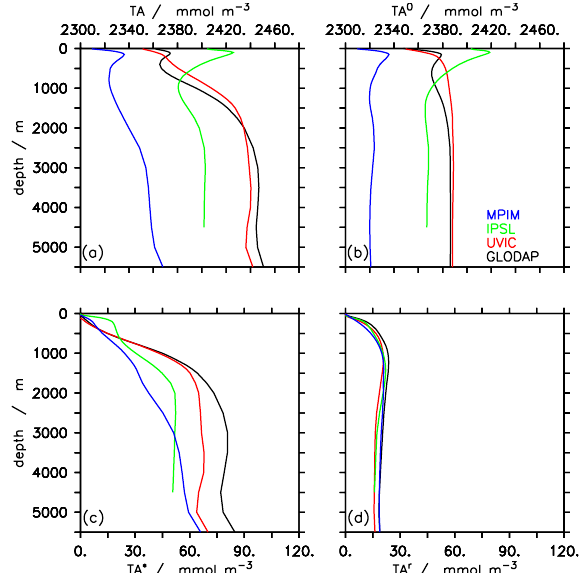
Figure 11. Global mean profiles of (a) TA, (b) TA 0 , (c) TA ∗ and (d) TA r in the GLODAP data set and in three different models. Prop- erties in (b–d) are diagnosed according to the methods described in Sect. 3. For each of the data sets a specific TA 0 algorithm was derived from annual mean data (models) or the annual compos- ite GLODAP data, respectively (see text for details and insert for colour code of the models and data